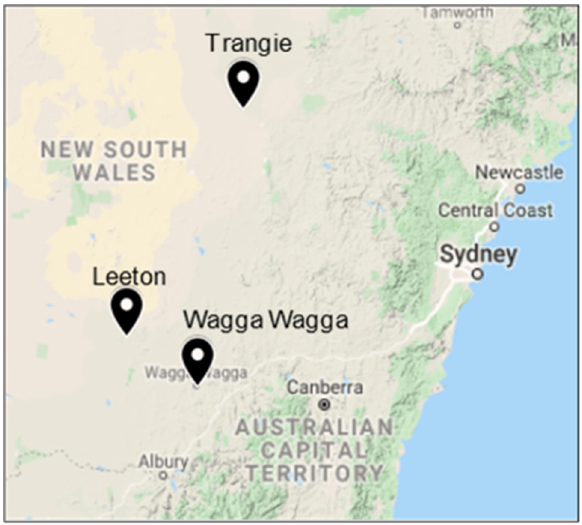
Figure 1. Location of the field experiments conducted in 2018 and 2019 at New South Wales Depart- ment of Primary Industries (NSW DPI) research facilities.